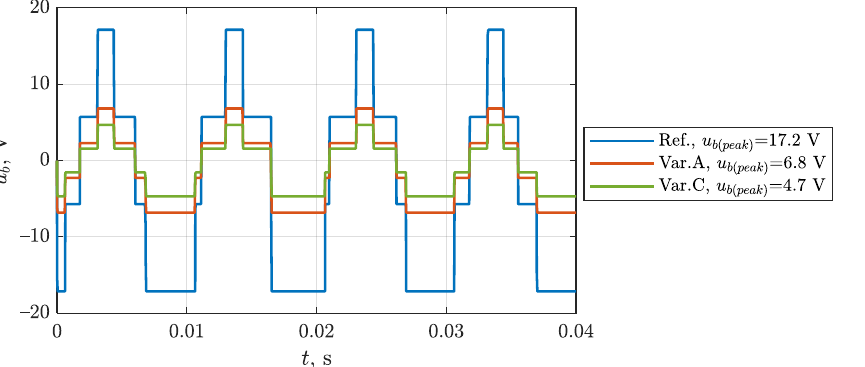
Figure 19. Bearing voltage waveforms for the two-level converter model for selected solution vari- ants.